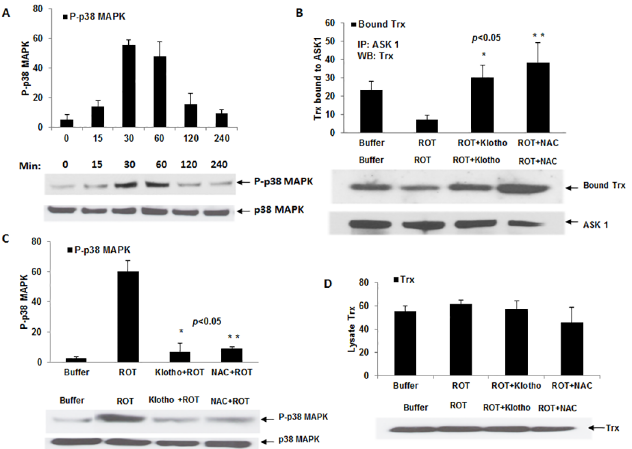
Fig 1. The effects of secreted Klotho on rotenone (ROT)-induced activation of p38 MAPK and Trx/ ASK1 complex levels in HEK 293 cells. (A) Plots of time course of ROT-mediated activation of p38-MAPK. Experiments were done at least twice and deviations are shown ± SEM. A representative Western blot is shown beneath plot. (B) Depiction of Trx/ASK1 complex levels in HEK 293 cells after pre-incubation with either control buffer alone or 200 pM Klotho/20 mM NAC for 40 min before adding the 5 μ M ROT to induce oxidative stress. ASK1 was immunoprecipitated (IP) with rabbit polyclonal ASK1 antibody and the co- precipitated Trx was revealed by Western blot. A representative Western blot of the samples is shown beneath. * p < 0.05 between ROT and Klotho + ROT. (C) Plots of p38 MAPK activation levels in HEK 293 cells treated with either Klotho or NAC as described in section B, with a representative Western blot. * p < 0.05 between ROT and Klotho + ROT. (D) Total lysate levels of Trx prior to IP. Where phosphorylation was studied, the same blot was stripped with Restore TM stripping buffer (Thermo Scientific) and re-probed with total p38 MAPK antibody for protein normalization. Digitized values of the WB of are shown in S1 and S2 Tables.